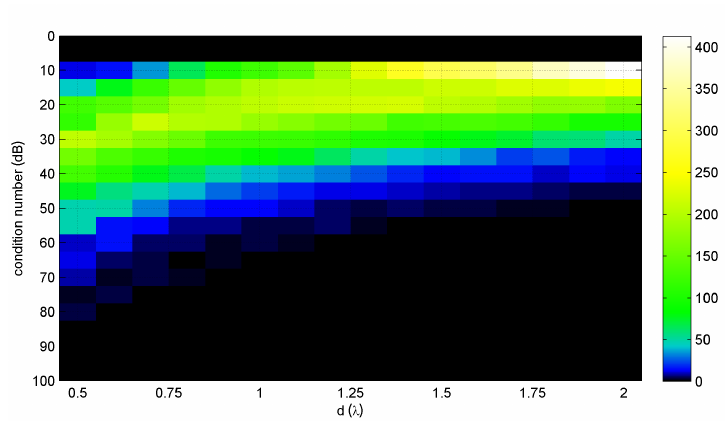
Figure 17. Distribution of the condition number as a function of the average distance d for the circular array with K = 50. Each column of the matrix in the image map is a histogram of the condition number.